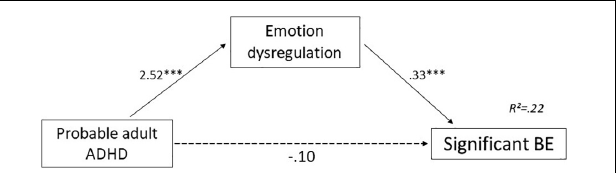
FIGURE 1 | Mediation effect of emotion dysregulation in the association between probable adult ADHD and significant BE. Unstandardized regression coefficient. ∗∗∗ p < 0.001. ADHD, attention-deficit/hyperactivity disorder; BE, binge eating. Dashed arrow: Non-significant effect. Black arrow: significant effect.